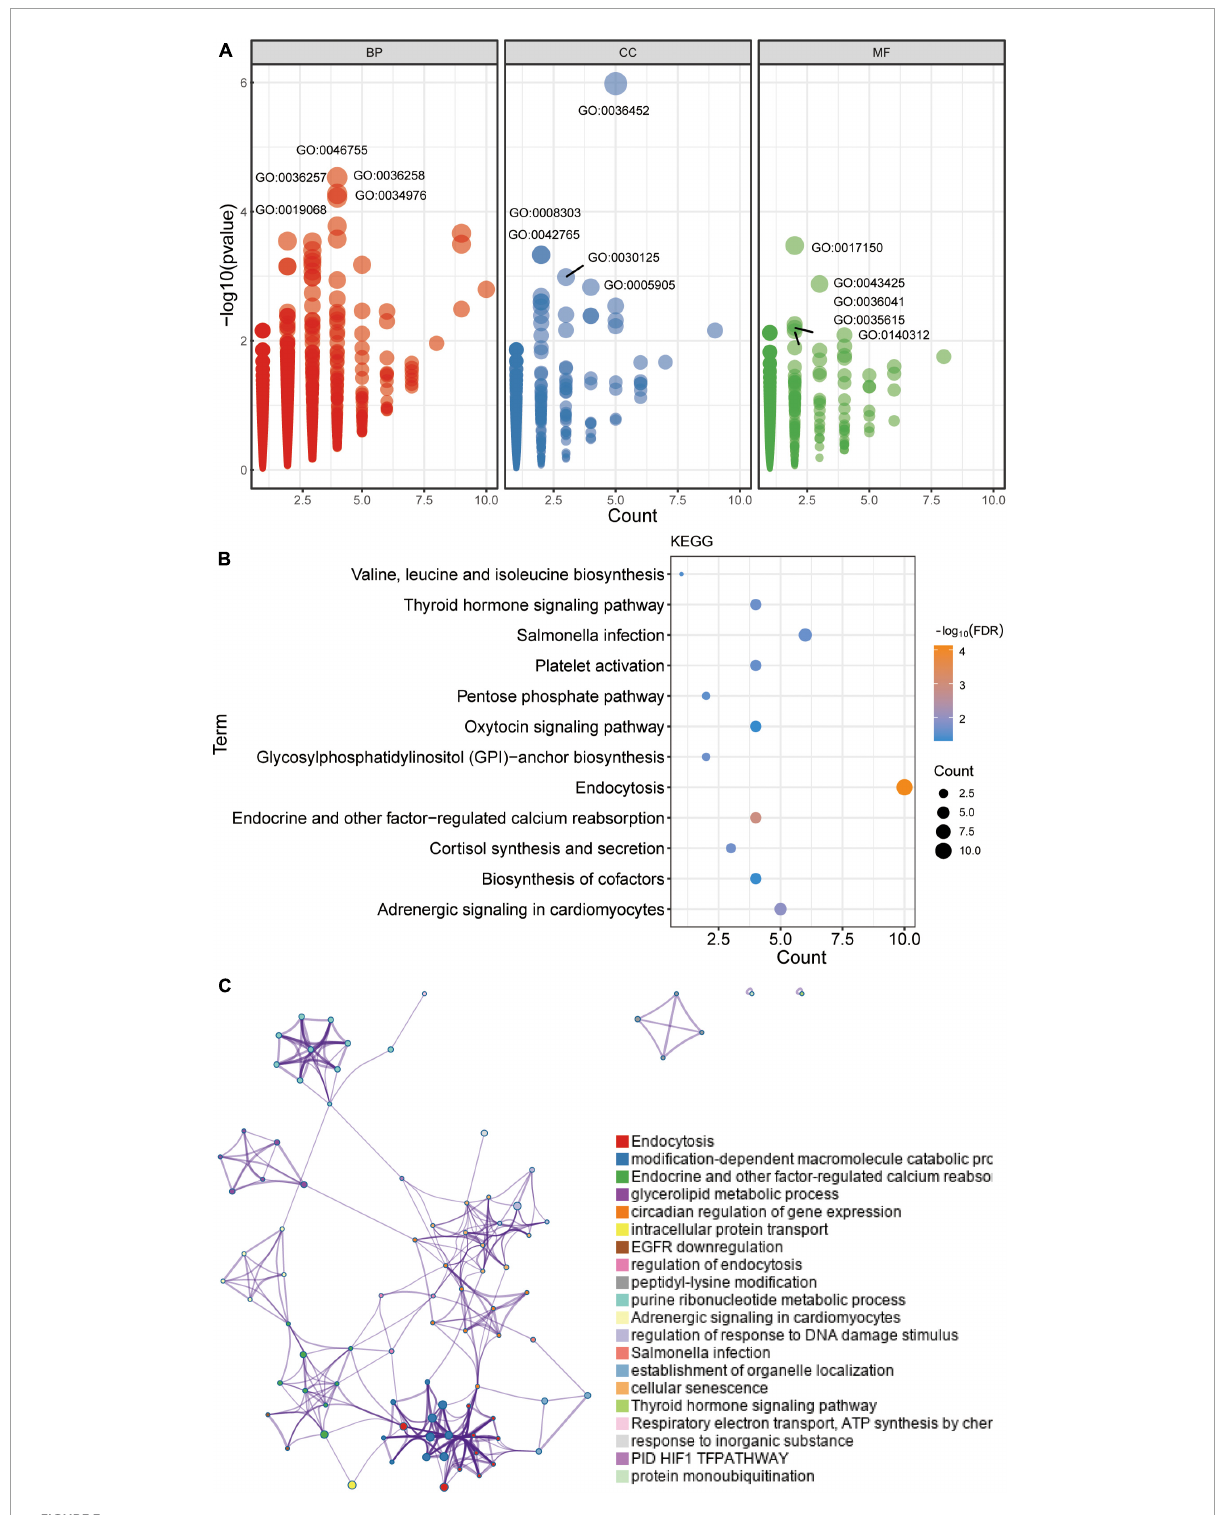
FIGURE3 Enrichment of GO and KEGG pathways for common DEGs. (A) GO enrichment analysis for common DEGs, including biological processes (BP), cellular components (CC), and molecular function (MF). (B) KEGG pathways enrichment analysis for common DEGs. FDR, false discovery rate. (C) Enrichment analysis for common DEGs using Metascape online